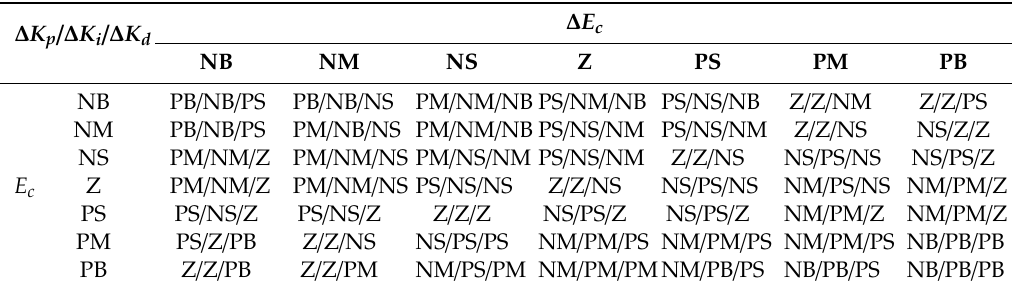
Figure 6. Membership function curve for ( a ) coupling error and ( b ) its rate. NB, negative big; NM, negative medium; NS, negative small; ZE, zero; PS, positive small; PM, positive medium; PB, positive big. Table 1. Fuzzy rules for ∆ K P , ∆ K I , and ∆ K D .